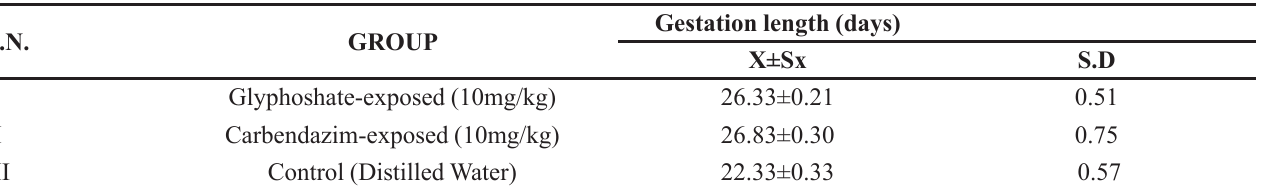
TABLE II - Gestation duration of female rats S.N.